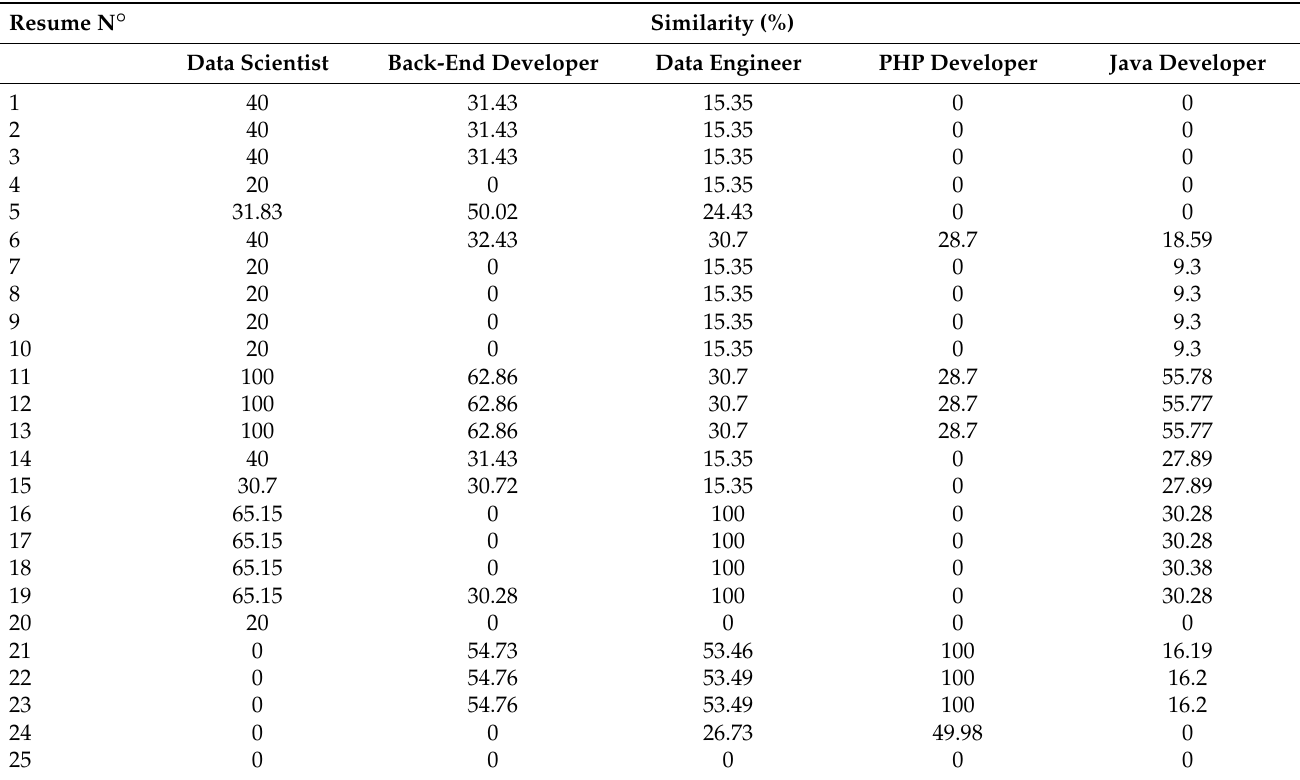
Table 4. Finding most matching